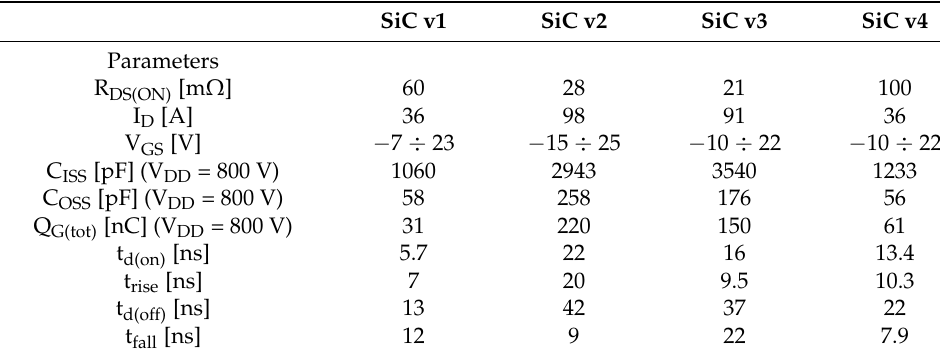
Table 2. Basic parameters of selected SiC